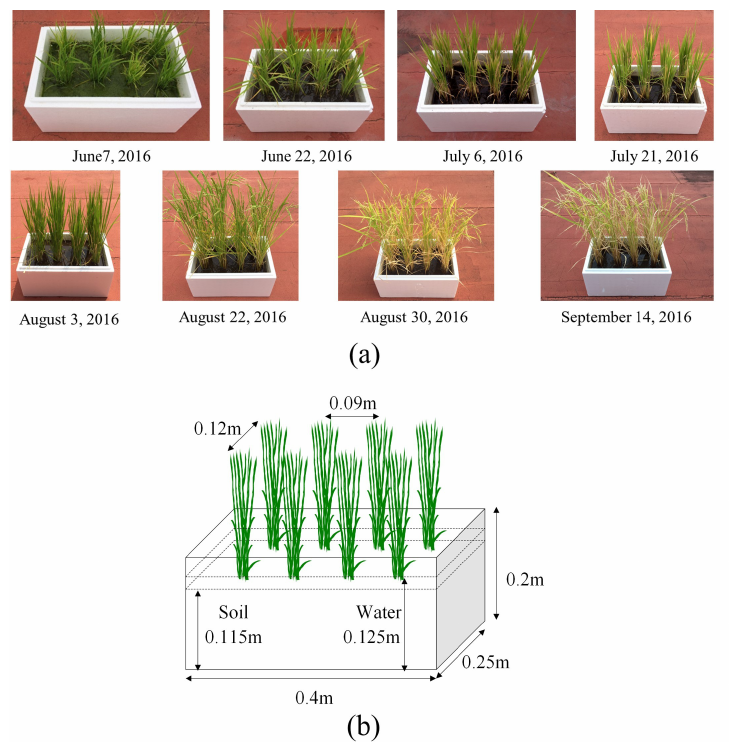
Figure 4. Photographs and layout of the rice used in experimental validation. ( a ) Photographs taken on each measurement date within the observation period from 7 June 2016 until 14 September 2016; ( b ) Layout of the eight rice samples uniformly planted within a container box with 0.115 m depth of soil and 0.125 m depth of